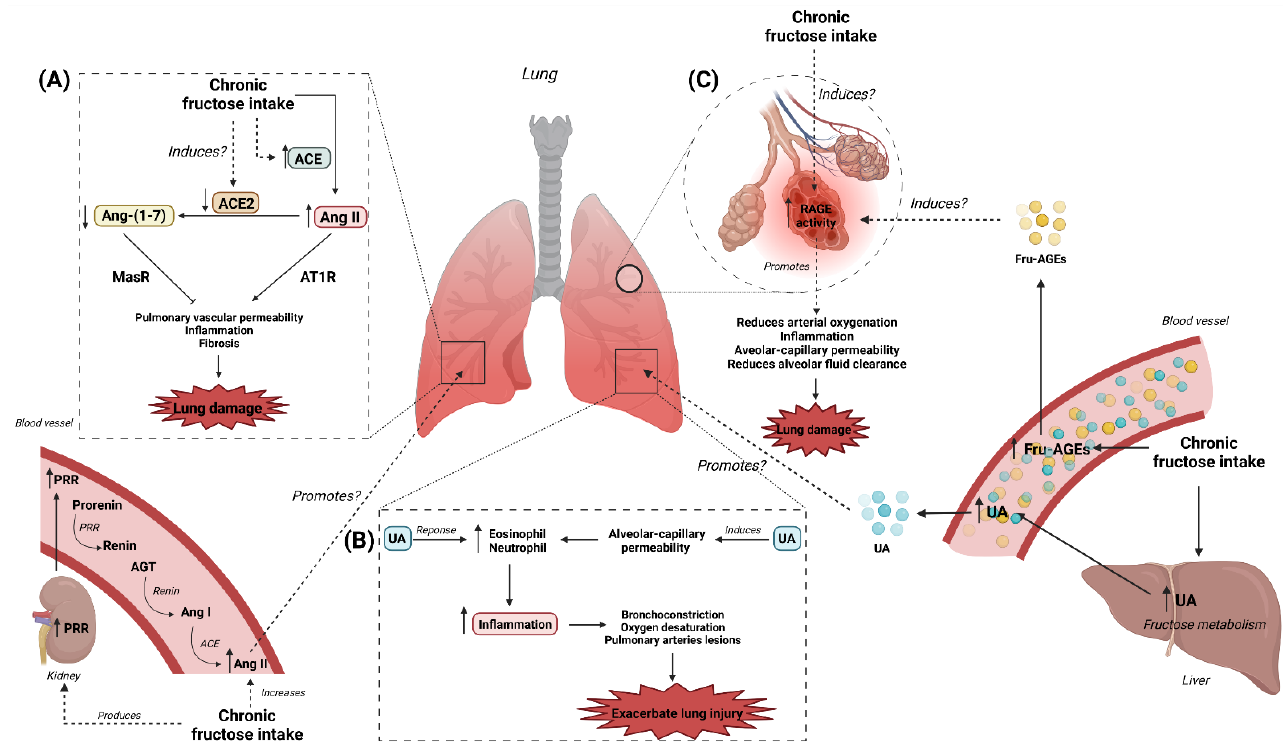
Figure 1. The possible role of chronic intake of fructose on lung injury through regulation of the RAS, UA, and AGEs production: ( A ) The lung damage is induced by the disbalance of the ACE/Ang II/ATR1 and ACE2/Ang-(1-7)/MasR axes [77,78]. Chronic intake of fructose induces the activation of the RAS in several tissues, including the lung. Fructose increases protein ACE and PRR [85], promoting the elevation of Ang II, while a decrease in ACE2 and Ang-(1-7) levels may induce the development of, or exacerbation of, lung injury [91,93]; ( B ) High UA levels are associated with exacerbating lung damage, promoting immune cell infiltration and inflammation [43–46]. UA is a byproduct of fructose metabolism, which is produced by purine degradation. Chronic intake of fructose increases UA levels by its metabolism in the liver [40,42], which may be a source of UA that plays an important role in the worsening of lung damage; ( C ) AGEs activate the RAGE in lung tissue, promoting lung damage by the activation of inflammation [109–111]. Chronic intake of fructose induces the formation of Fru-AGEs in plasma and/or tissue, which may activate the RAGE in the lung, participating in the development of, or exacerbating, the lung damage [115,116]. AGT: Angiotensinogen; ACE: angiotensin-converting enzyme; Ang II: angiotensin II; ATR1: angiotensin II receptor type 1; MasR: Mas receptor; PRR: (pro)renin receptor; UA: uric acid; AGEs: advanced glycation end products; Fru-AGEs: fructose-derived AGEs; RAGE: Receptor for AGEs. The Figure has gotten the copyright permission. Created with BioRender.com (accessed on 25 August